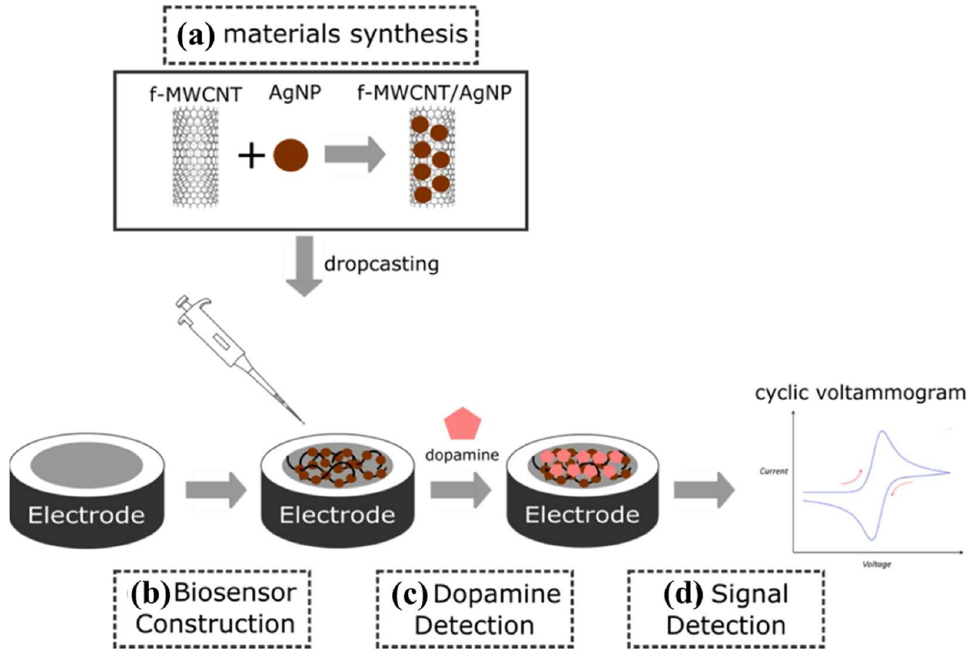
Figure 5. Schematic illustration of the (f-MWCNT/AgNP) nanocomposites-modified electrode fabrication process (Reprinted with permission from Ref. [49]. Copyright 2021, Nanocomposites).